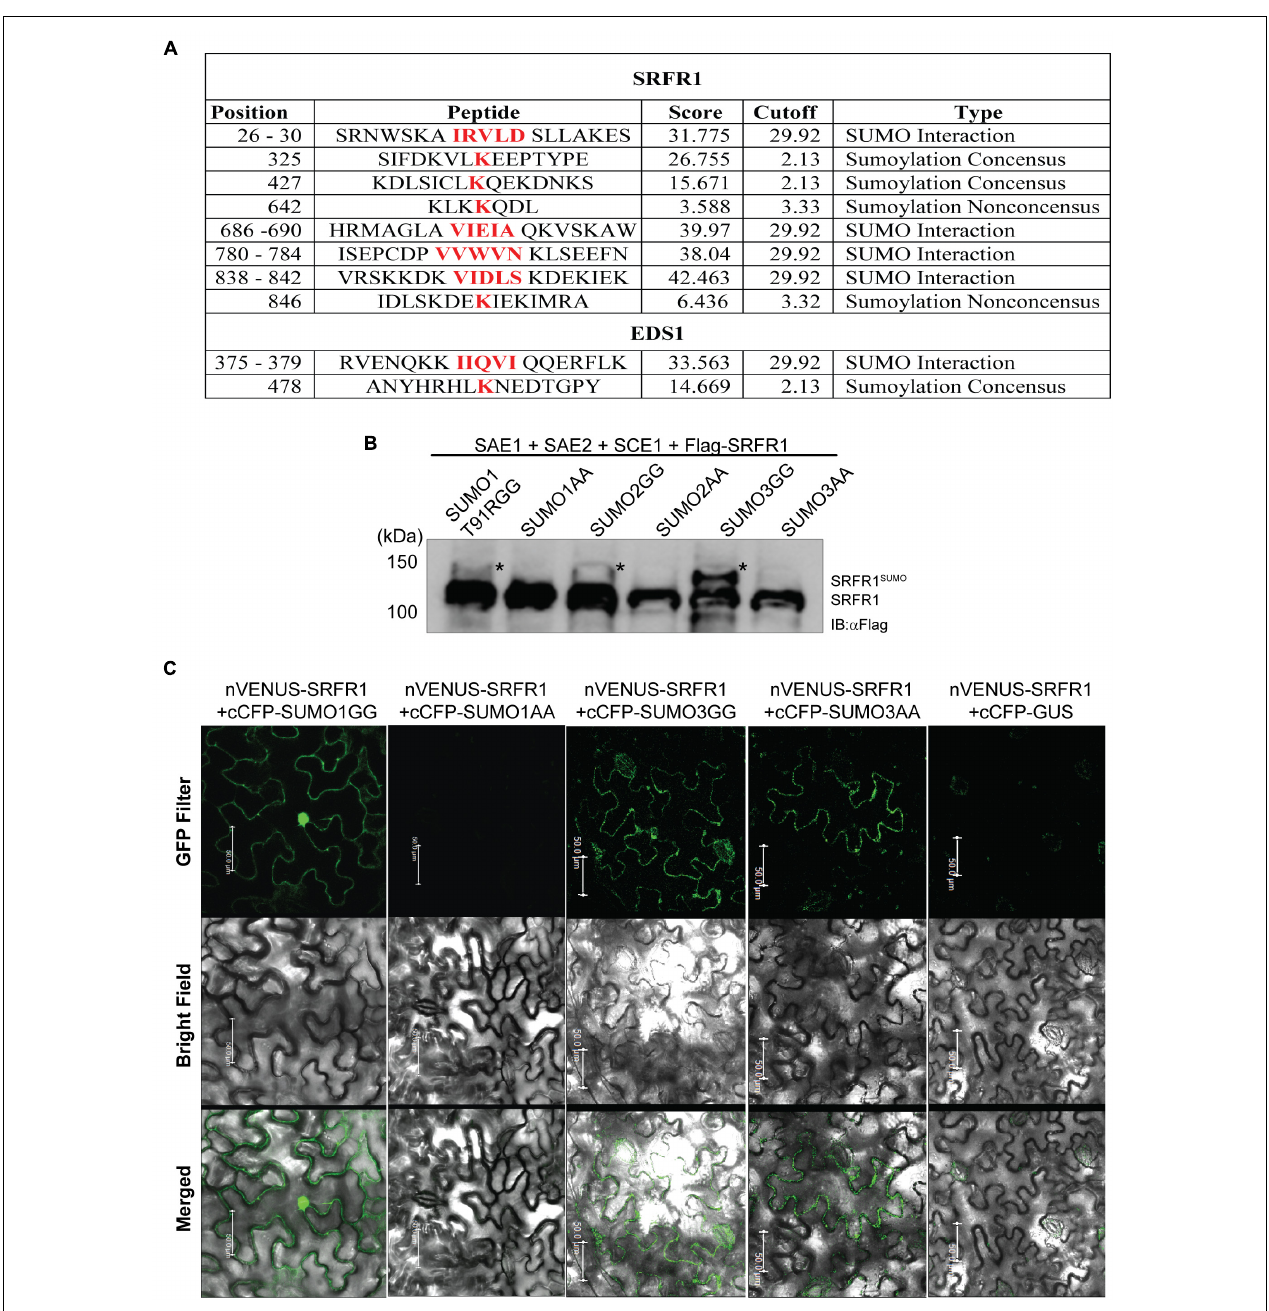
FIGURE 3 | SRFR1 is a SUMOylation and SUMO-binding candidate. (A) Prediction of putative SUMOylation and SIM motifs in SRFR1 and EDS1. In silico prediction was performed using SUMOsp2.0 tool. (B) SRFR1 is SUMOylated by SUMO1 T91R, SUMO2, or SUMO3 GG forms in Escherichia coli SUMOylation reconstitution system. Immunoblot was probed with anti-FLAG antibodies to detect FLAG-SRFR1. Migration position of molecular weight standards (in kDa), SUMOylated or non-SUMOylated SRFR1 (SRFR1 SUMO or SRFR1, respectively), is indicated. (C) Bimolecular fluorescence complementation (BiFC) panels of co-expressed nVenus-SRFR1 with cCFP-clones of SUMO1 GG/AA, SUMO3 GG/AA, or negative control GUS ( β -glucuronidase). Images were acquired using a confocal microscope with GFP or bright-field filters. Merged images of YFP with bright field are shown. Scale bar = 50 µ m.